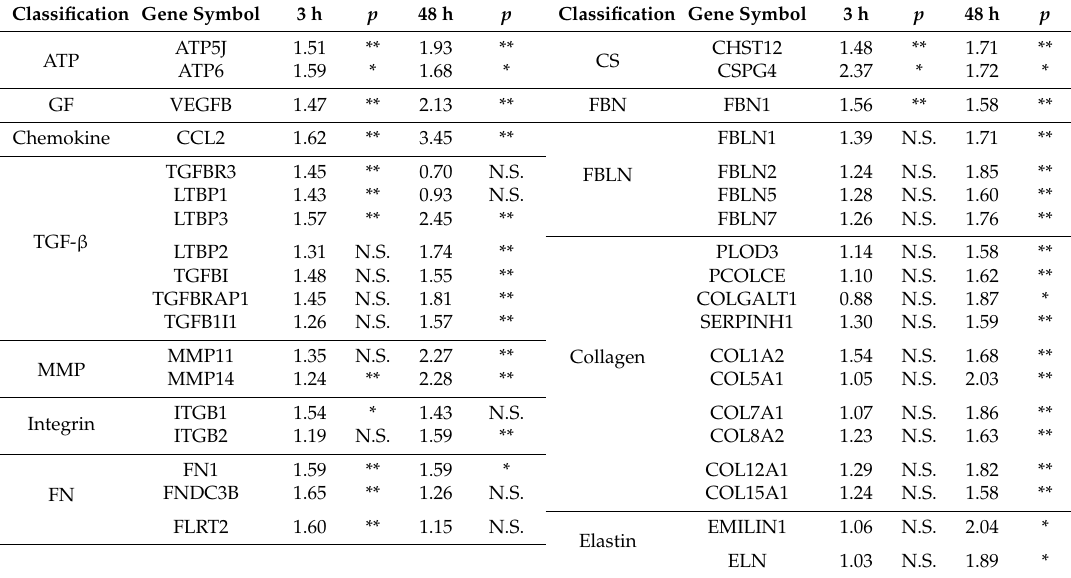
Table 1. Fold increase of the gene expressions at 3 and 48 h after Teslar treatment relative to the control in collagen gel-cultured